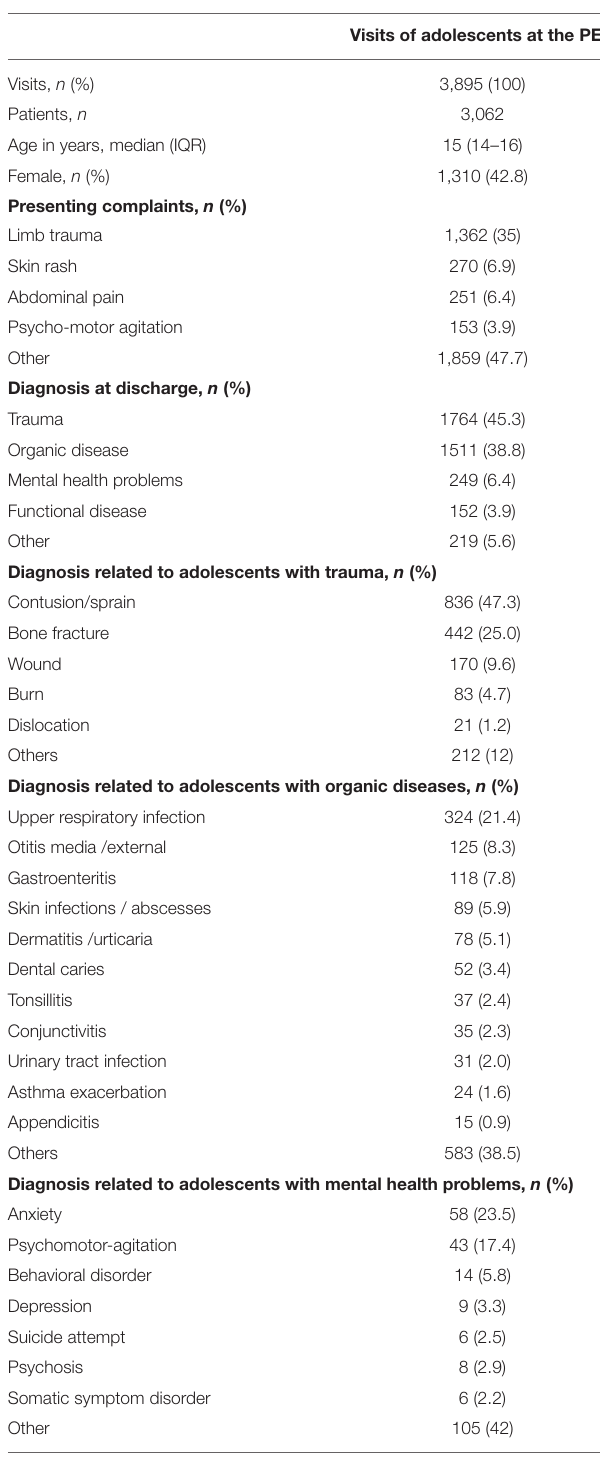
TABLE 1 | Main characteristics of the adolescents accessing the